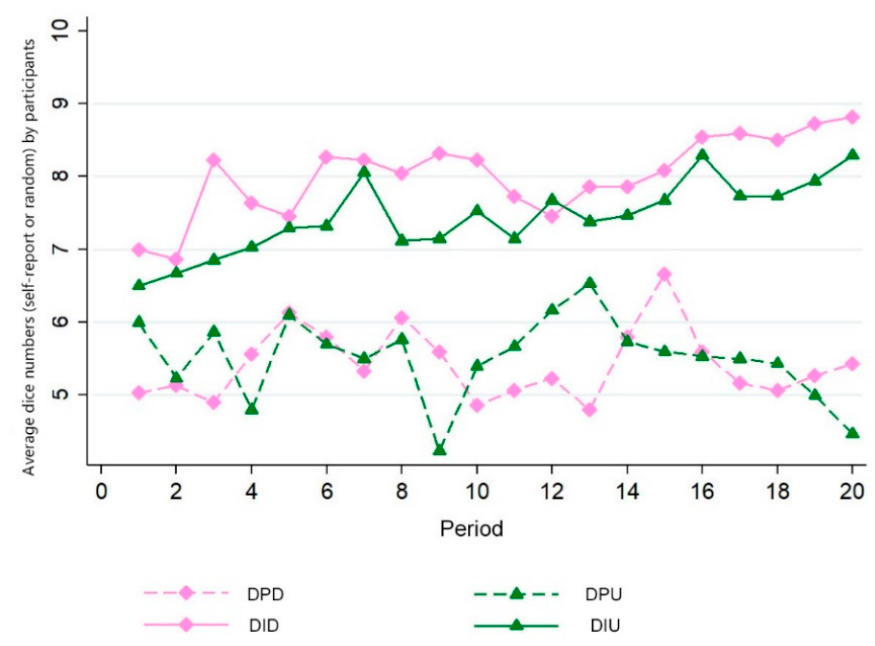
Figure 2. Changing trend of average numbers in four treatments.